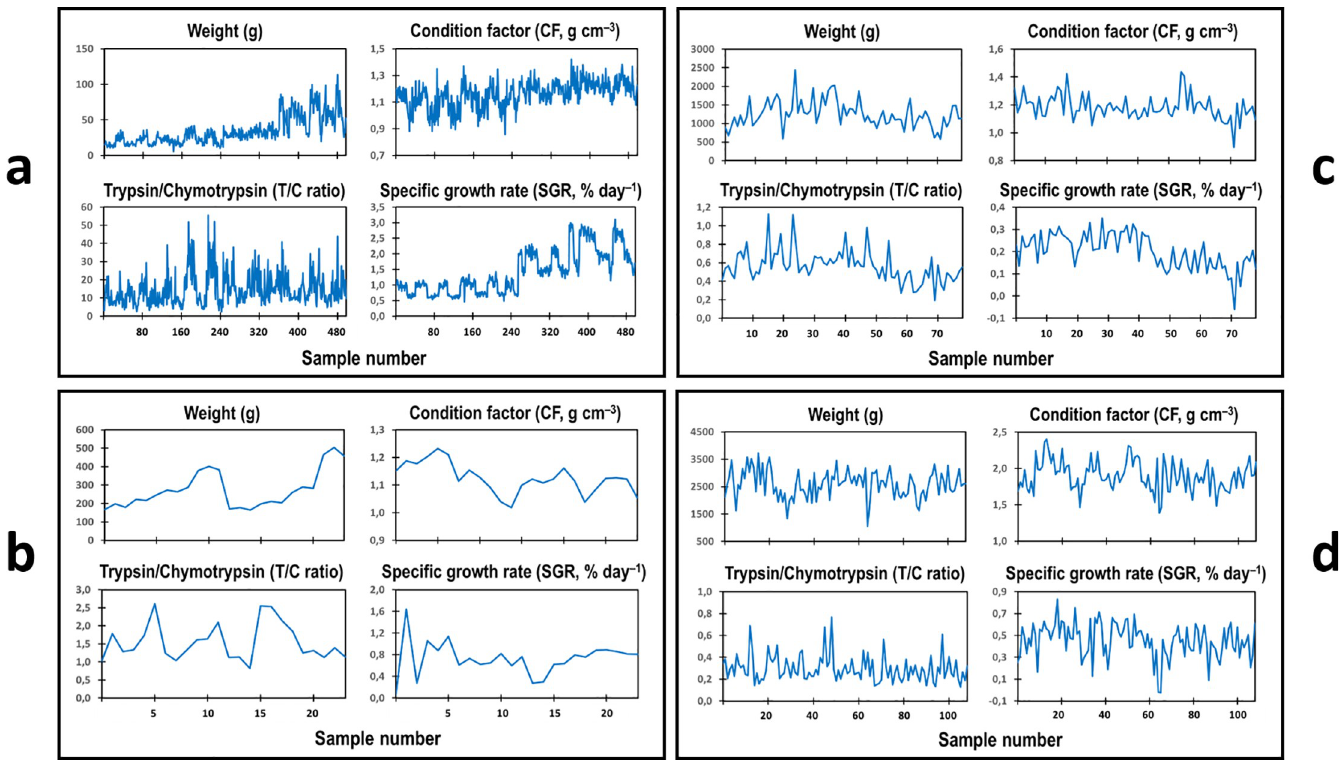
Fig 1. Datasets with weight, pyloric caecal T/C ratio, CF, and SGR. (a) Data1: Atlantic salmon at juvenile stage with 499 data points (original data from [9]). (b) Data2: Atlantic salmon at post-smolt stage with 24 data points (original data from [11]). (c) Data3: Atlantic salmon at adult stage with 79 data points (original data from [10]). (d) Data4: Rainbow trout at adult stage during maturation with 109 data points (original data from [13]). Weight, T/C ratio, CF, and SGR values will be normalized to a range of between –1 and +1 for training and testing our models.